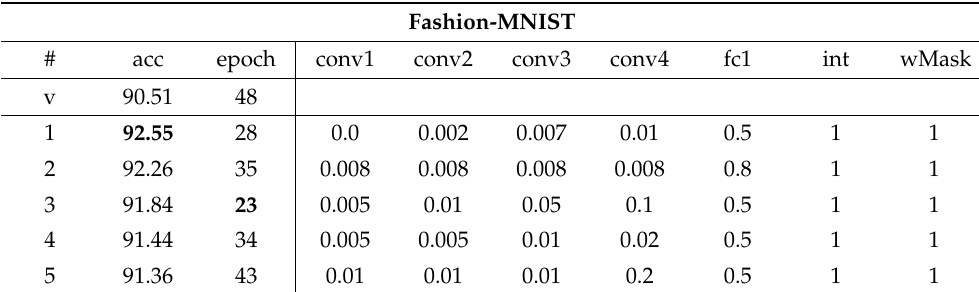
Figure 6. Performances of LIM and vanilla dropout methods on the fashion-MNIST dataset, trained and tested for 50 epochs. Curves correspond to Table 3 scores; black: vanilla, red: 1, orange: 2, green: 3, blue: 4, purple: 5. Table 3. Accuracy scores, parameter tuning, and convergence times for different experiments on the fashion-MNIST dataset. The first row holds the best accuracy score for the vanilla dropout version and the epoch at which it was attained.